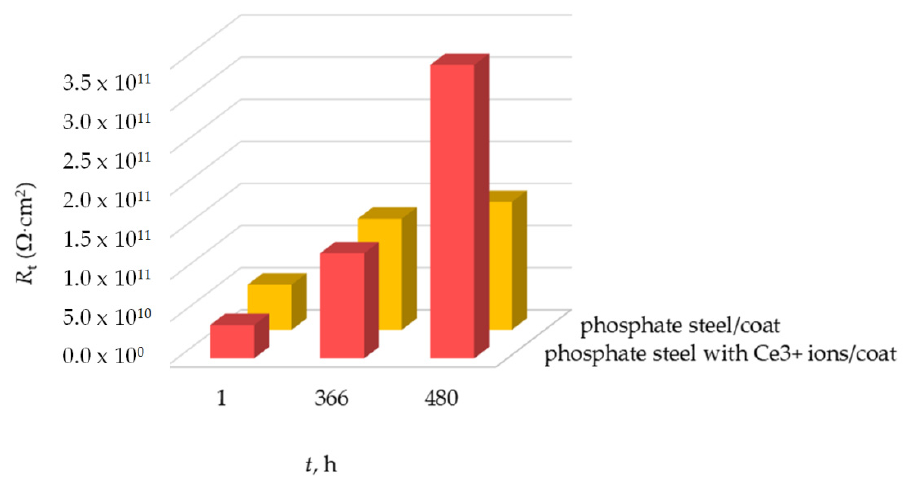
Figure 7. Total resistance value for bare steel/coat and phosphate steel with Ce 3+ /coat immersion in 3.5 wt.% NaCl solution for 1, 366, and 480 h.